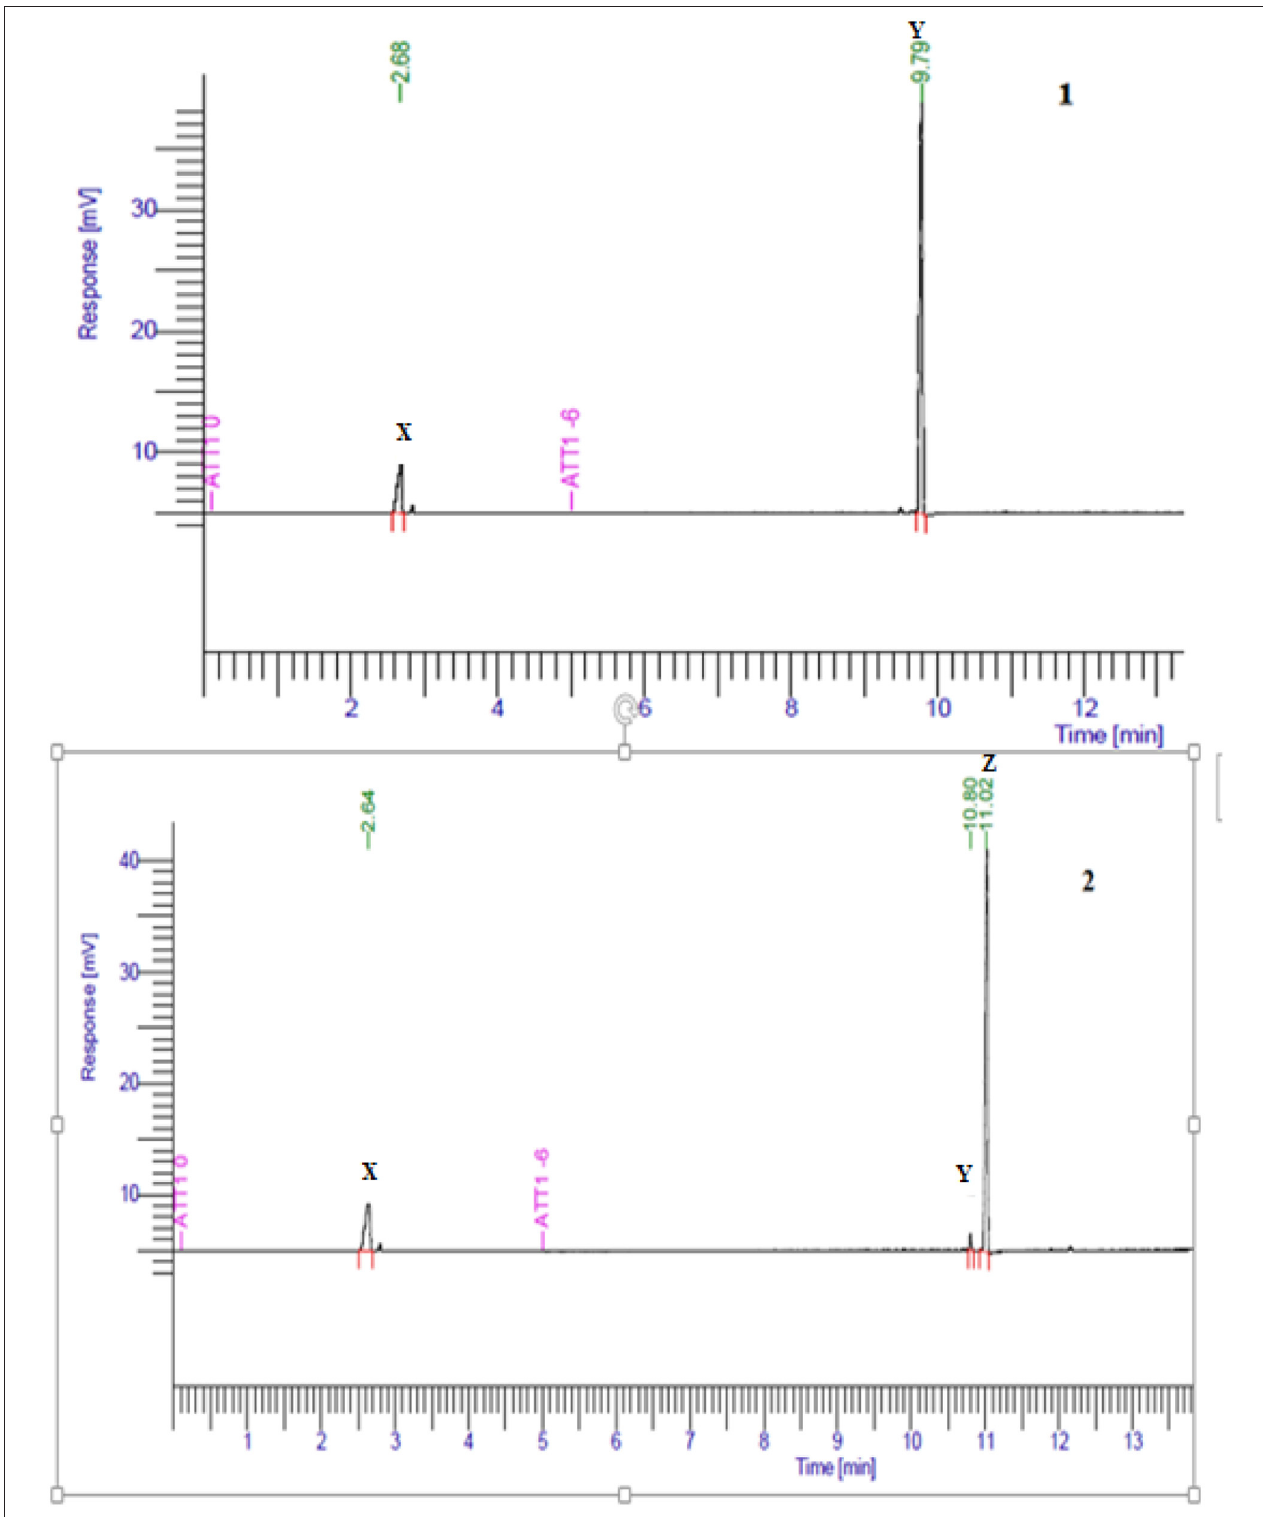
FIGURE 4 | Gas chromatogram profile of purified esters of geranyl butyrate (1Y) and citronellyl butyrate (2Z) obtained after partial purification.